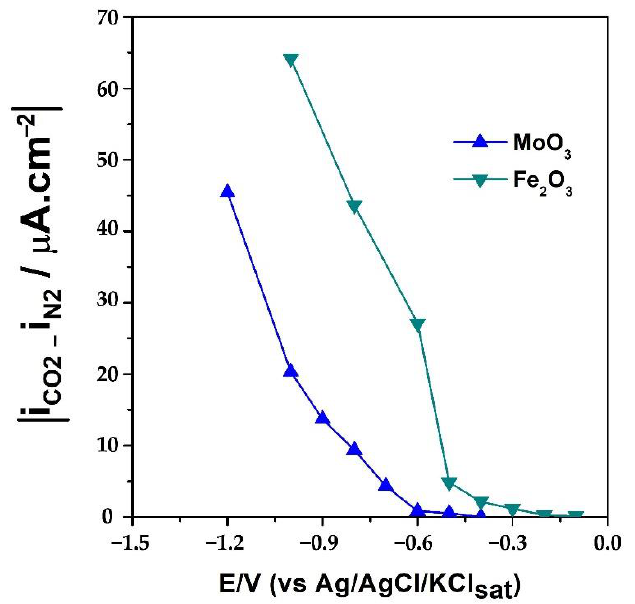
Figure 4. Profile of current associated with CO 2 reduction faradaic processes for examined TMO materials as a function of applied potential in square-wave chronoamperometric experiments.